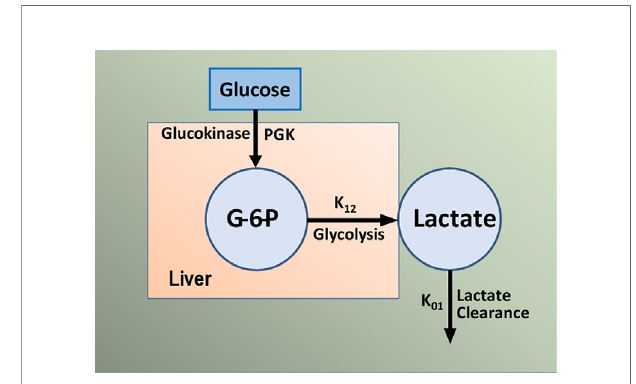
FIGURE 18 | Simple model of glucose/lactate kinetics. Glucose enters hepatocytes, independent of insulin, and follows the glycolytic pathway via glucokinase. Lactate exits the liver and is a surrogate for glucokinase activation and “ glucose effectiveness ” .